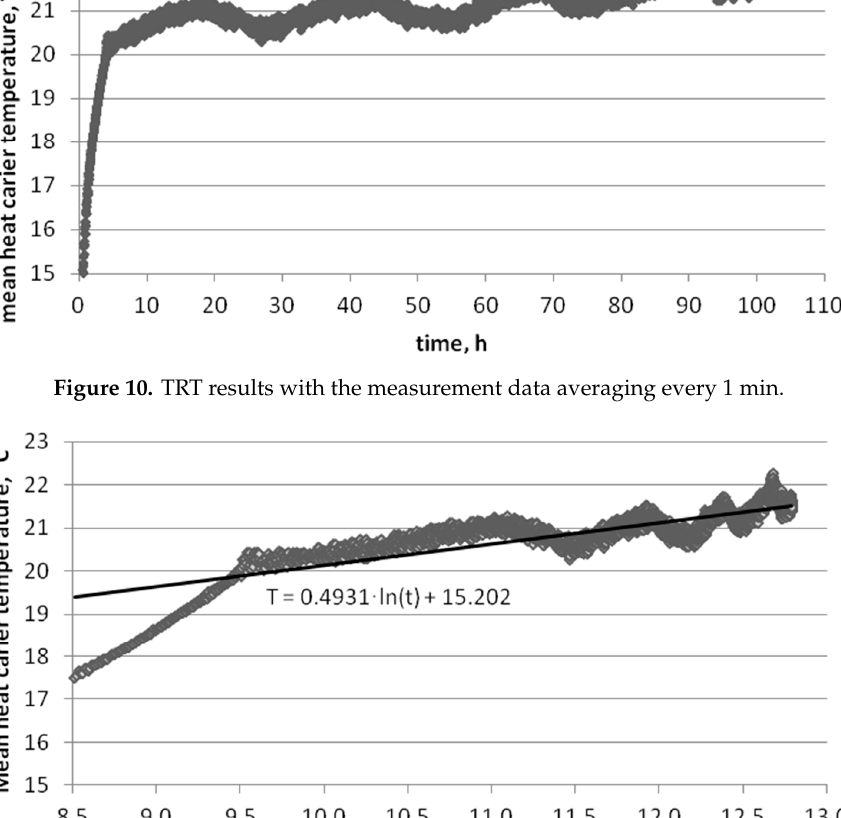
Figure 11. TRT results with the measurement data averaging every 1 min in a semi-logarithmic plot, together with the linear regression equation.